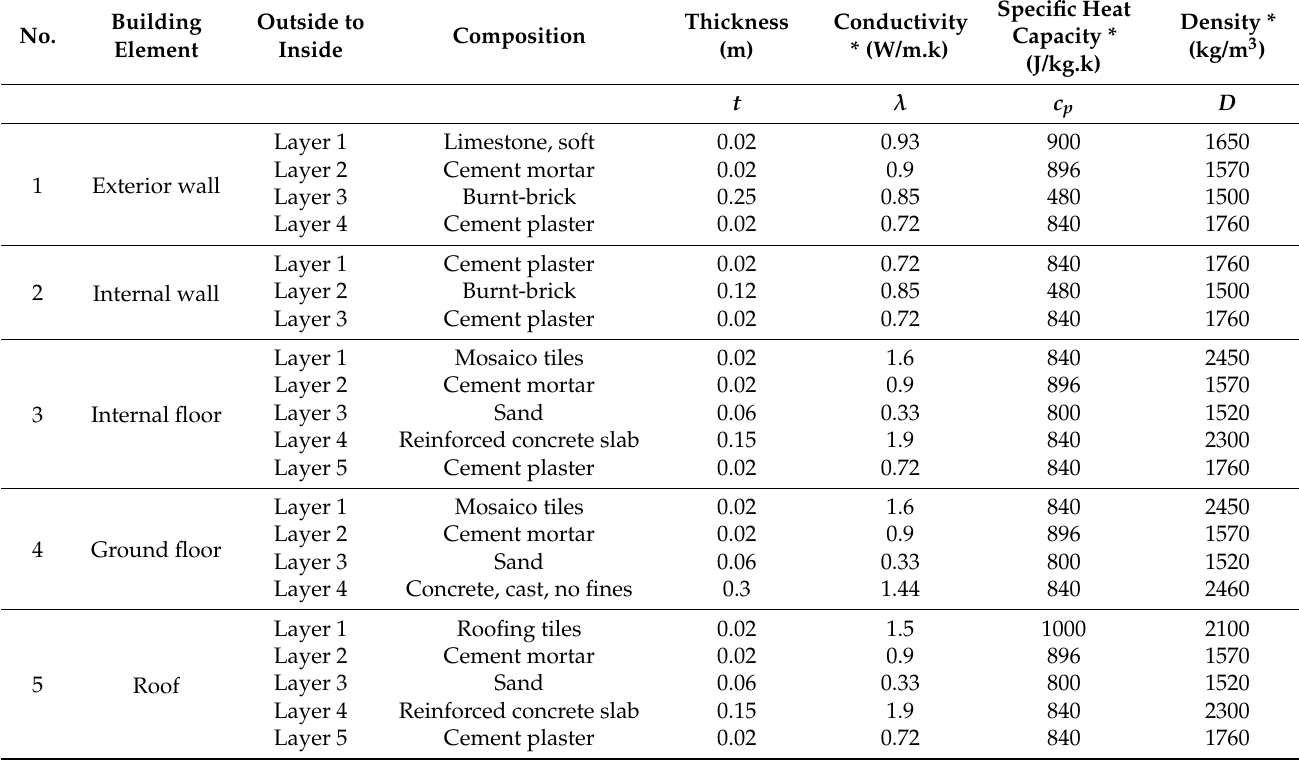
Table 2. Thermal properties of the building elements of the base